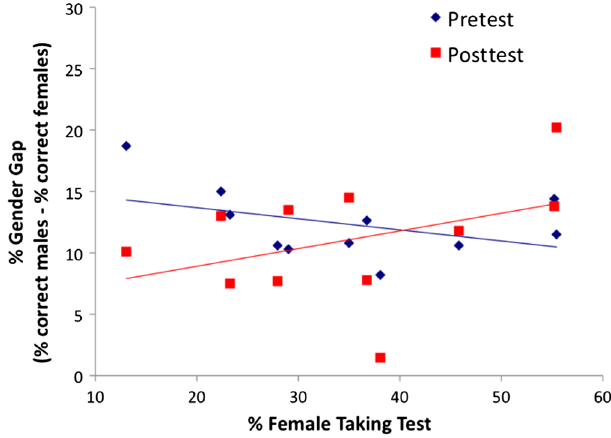
FIG. 5 (color online). Scatter plot summarizing the relation- ship between the percentage of gender gap on the FCI and the percentage of women taking the pre- and posttest. Each dot represents one of the 10 institutions (though in some cases one institution is represented by two dots, each using a different teaching method). We find no strong relationship between the percentage of women taking the concept inventory and the gender gap in score on either the pre- or